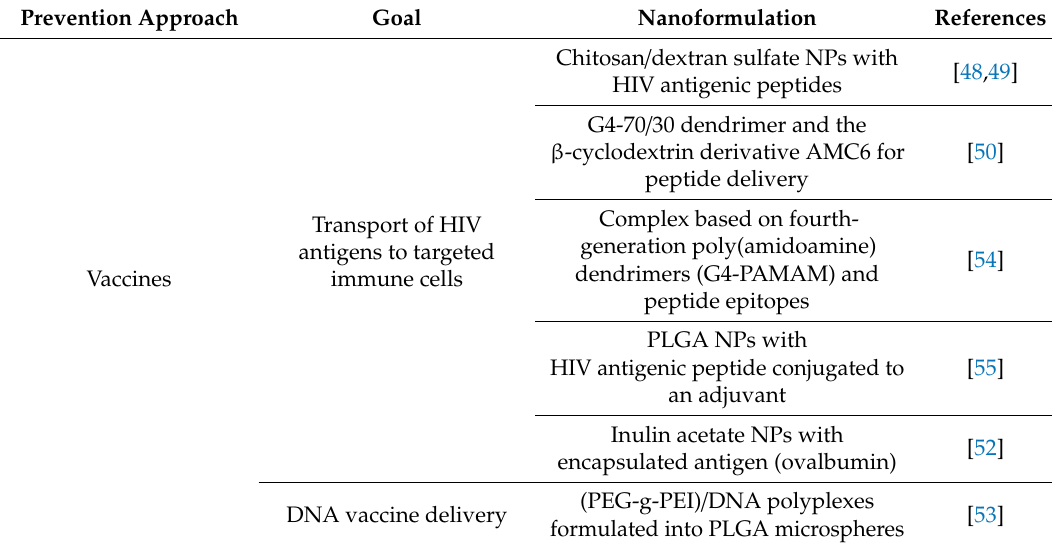
Table 1. Nanotechnology approaches for HIV